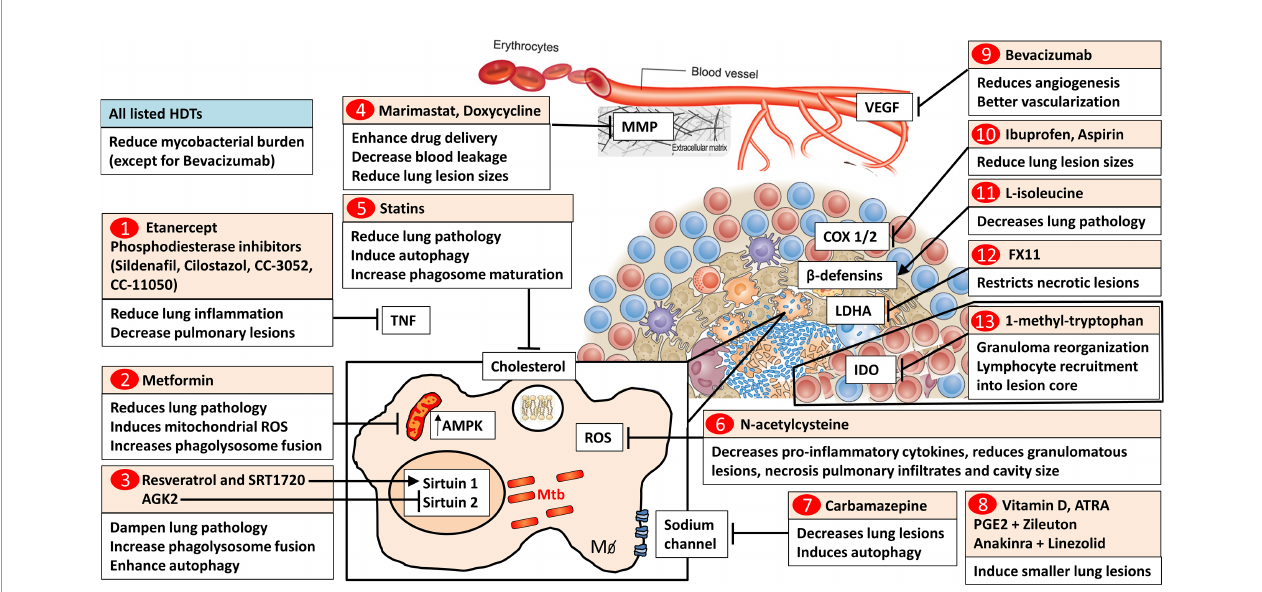
FIGURE 1 | Host-directed drugs targeting molecular pathways within lung granulomas. 1) TNF blockers such as soluble TNF receptor 2 fusion protein, etanercept and phosphodiesterase inhibitors (Sildena fi l, Cilostazol, CC-3052, and CC-11050) reduce lung in fl ammation and pulmonary pathology. 2) The antidiabetic drug metformin inhibits mitochondrial respiratory-chain complex 1 and increases AMPK levels. Metformin reduces lung pathology and in Mtb-infected macrophages induces mitochondrial ROS and increases phagolysosome fusion. 3) Histone deacetylase Sirtuin 1 activators (Resveratrol, SRT1720) and Sirtuin 2 inhibitor (AGK2) dampen lung pathology, increase phagolysosome fusion and autophagy. 4) Broad-spectrum metalloproteinase (MMP) inhibitor, Marimastat, enhances anti-tubercular drug delivery and reduces blood vessel leakage. Doxycycline reduces lung lesion sizes. 5) Statins, cholesterol-lowering drugs, reduce lung pathology. In macrophages, statins induce autophagy and increase phagosome maturation. 6) The antioxidant N-acetylcysteine (NAC) decreases pro-in fl ammatory cytokines, reduces tuberculous granuloma lesions, necrosis, pulmonary in fi ltrates, and cavity size. 7) Carbamazepine, a sodium channel blocker, decreases lung lesions and induces autophagy in macrophages. 8) Vitamin D and Vitamin A metabolite (all-trans retinoic acid, ATRA), PGE2 and Zileuton, Anakinra and Linezolid induce smaller lung lesions. 9) VEGF blocker (Bevacizumab) reduces angiogenesis and induces functionally better vascularized granulomas. 10) Nonsteroidal anti-in fl ammatory drugs (Ibuprofen and Aspirin) block cyclooxygenases and reduce lung lesion sizes. 11) The amino acid L -isoleucine decreases pulmonary pathology through the induction of b -defensins. 12) Lactate dehydrogenase A inhibitor (FX11) restricts necrotic lung lesions. 13) The IDO inhibitor, 1-methyl-tryptophan, results in the reorganization of granuloma architecture increasing lymphocyte recruitment into the lesion core. 1-13) All listed HDT candidates reduce mycobacterial burden except for bevacizumab. TNF, Tumor Necrosis Factor; AMPK, AMP-activated protein kinase; Sirtuin, Silent mating type information regulation 2 homolog; ROS, Reactive Oxygen Species; MMP, metalloproteinases; VEGF, Vascular endothelial growth factor; COX, cyclooxygenases; LDHA, Lactate dehydrogenase A; FX11, 7-Benzyl-2;3-dihydroxy-6-methyl-4-propyl-naphthalene-1-carboxylic; IDO, indoleamine 2;3-dioxygenase; ATRA, All-trans retinoic acid; PGE2, Prostaglandin E2. Image of the granuloma structure adapted from reference (3), Nature Publishing Group. Image of the blood vessel structure adapted from reference (8), Wiley Publishing Group